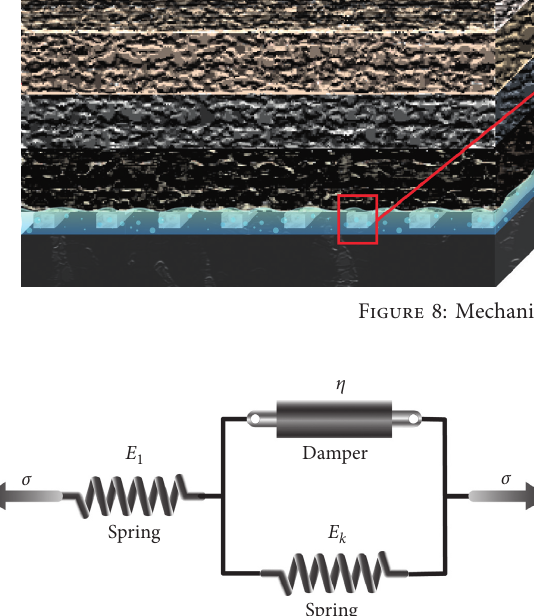
Figure 9: Illustration of the rheological model.